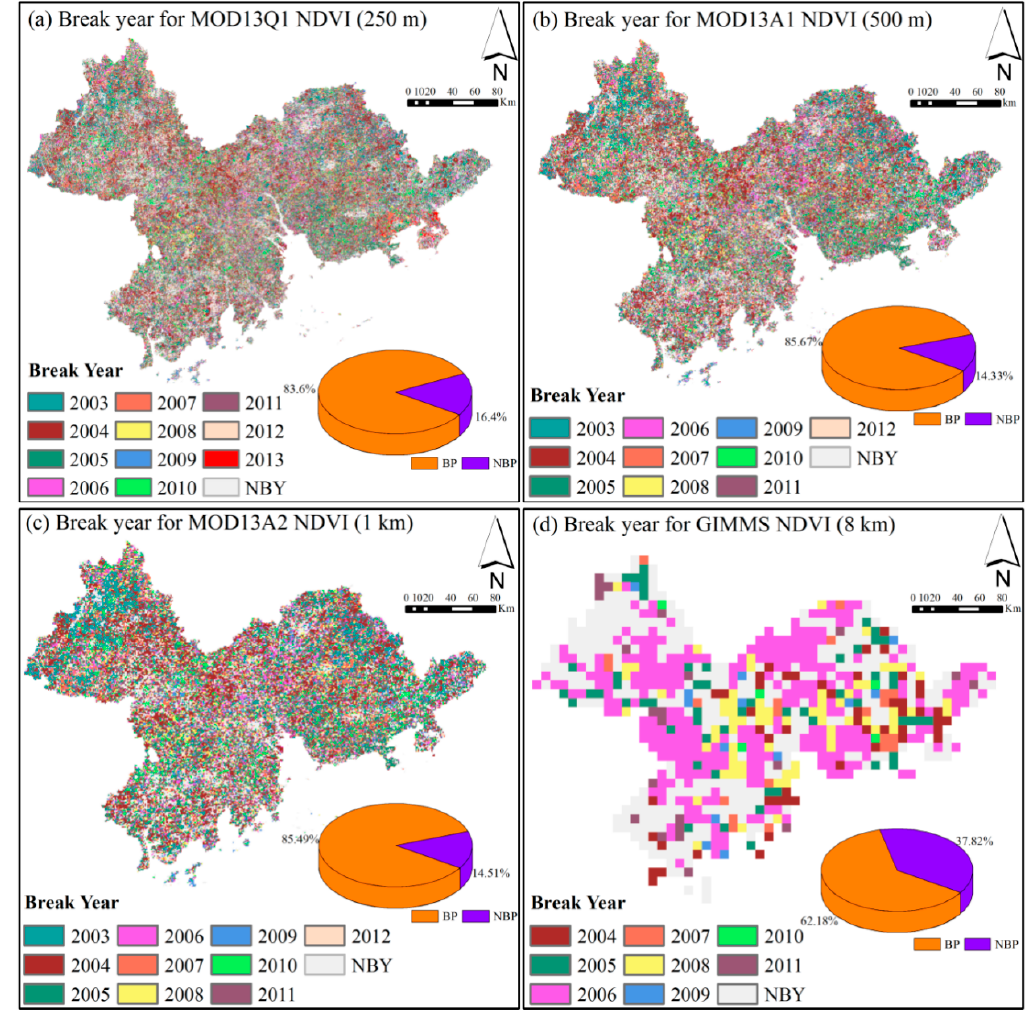
Figure 5. Comparison of the break year for MODIS NDVI and GIMMS NDVI in the PRD: ( a ) indicates the break year for MOD13Q1 NDVI, ( b ) indicates the break year for MOD13A1 NDVI, ( c ) indicates the break year for MOD13A2 NDVI and ( d ) indicates the break year for GIMMS NDVI; NBY denotes ‘no break year’, BP denotes the proportion of pixel numbers with breakpoints, NBP denotes the proportion of pixel numbers without breakpoints.